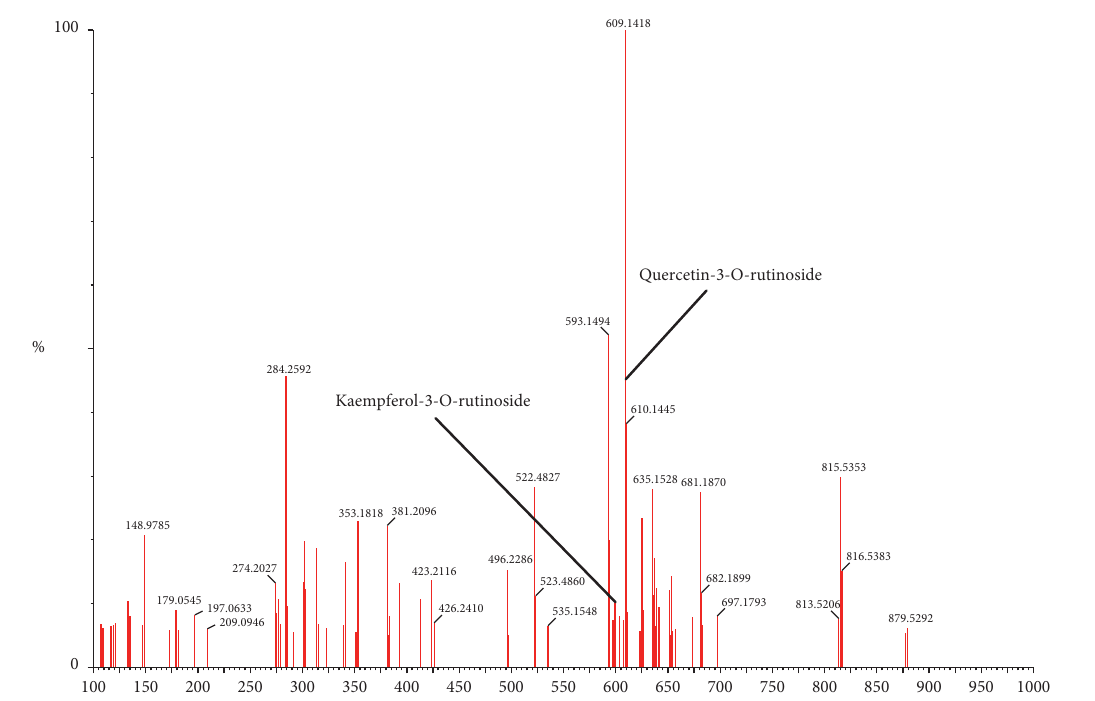
Figure 8: Total MS chart representing molecular ion peaks of identified compounds from the active fraction analyzed by LC/MS.